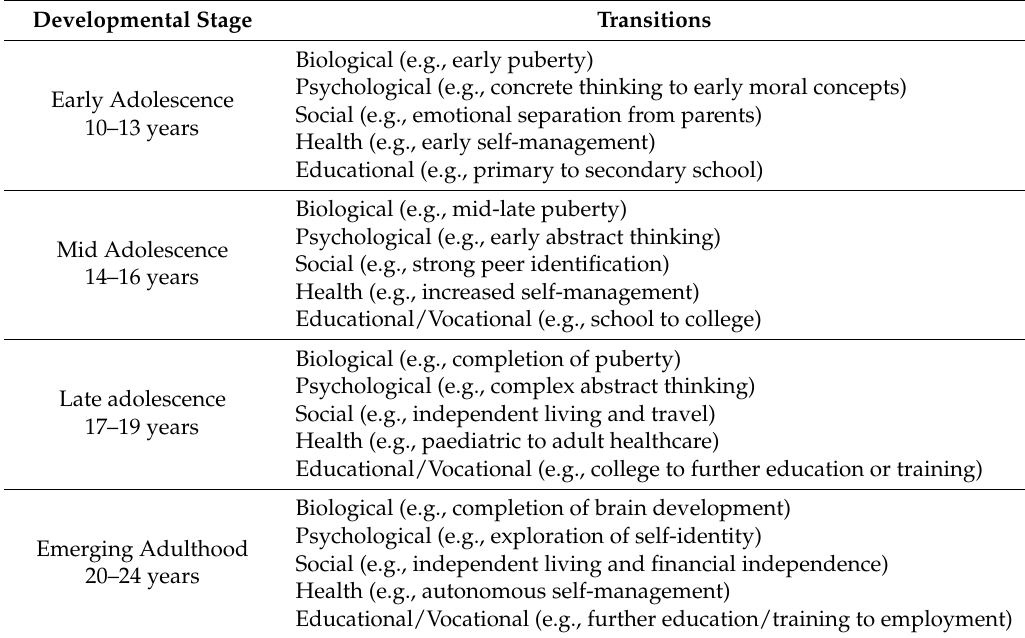
Table 1. Some key transitions associated with developmental stages of adolescence and young